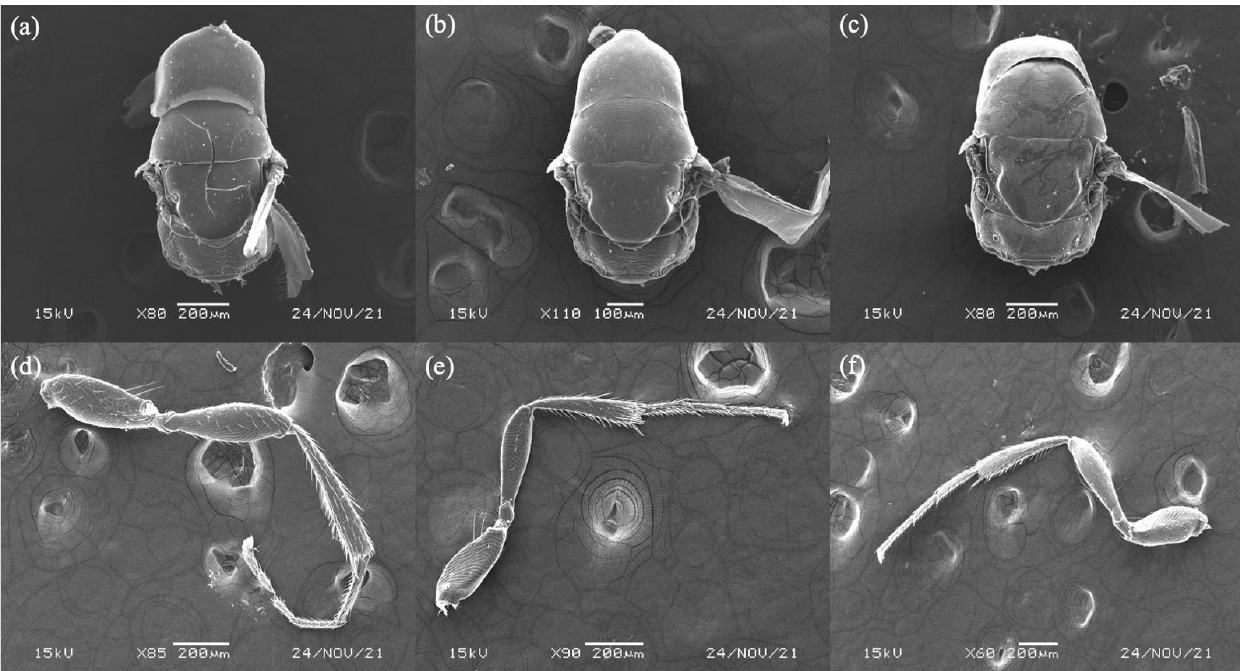
Figure 3. Mesosoma, dorsal view of ( a ) Philotrypesis guangdongensis sp. n.; ( b ) P. yunnanensis sp n.; ( c ) P. fujianensis sp. n. Hind leg of ( d ) P. guangdongensis ; ( e ) P. yunnanensis ; ( f ) P. fujianensis